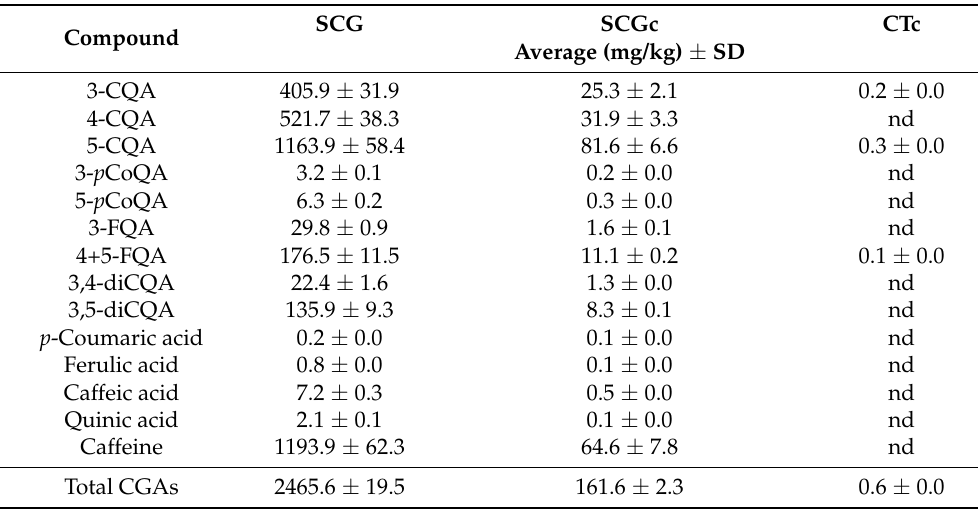
Table 2. Chlorogenic acids ( n = 9), phenolic acids ( n = 4), and caffeine content in spent coffee grounds, spent coffee grounds-enriched cookies, and control cookies samples. Data are displayed as average value (mg/kg) and standard